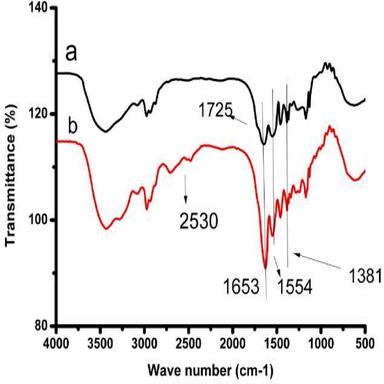
FT-IR spectra of (a): carboxyl-functionalized PNIPAM (b): thiolfunctionalized PNIPAM microgels.